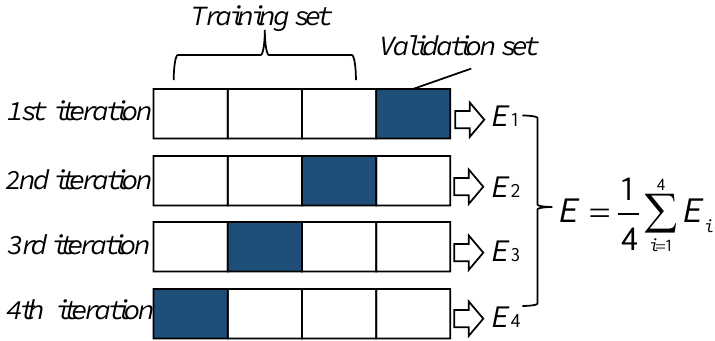
Figure 8. Cross-validation. Table 3. Selection of model